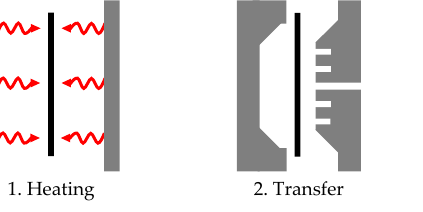
Figure 1. Process chain for thermoplastic composites